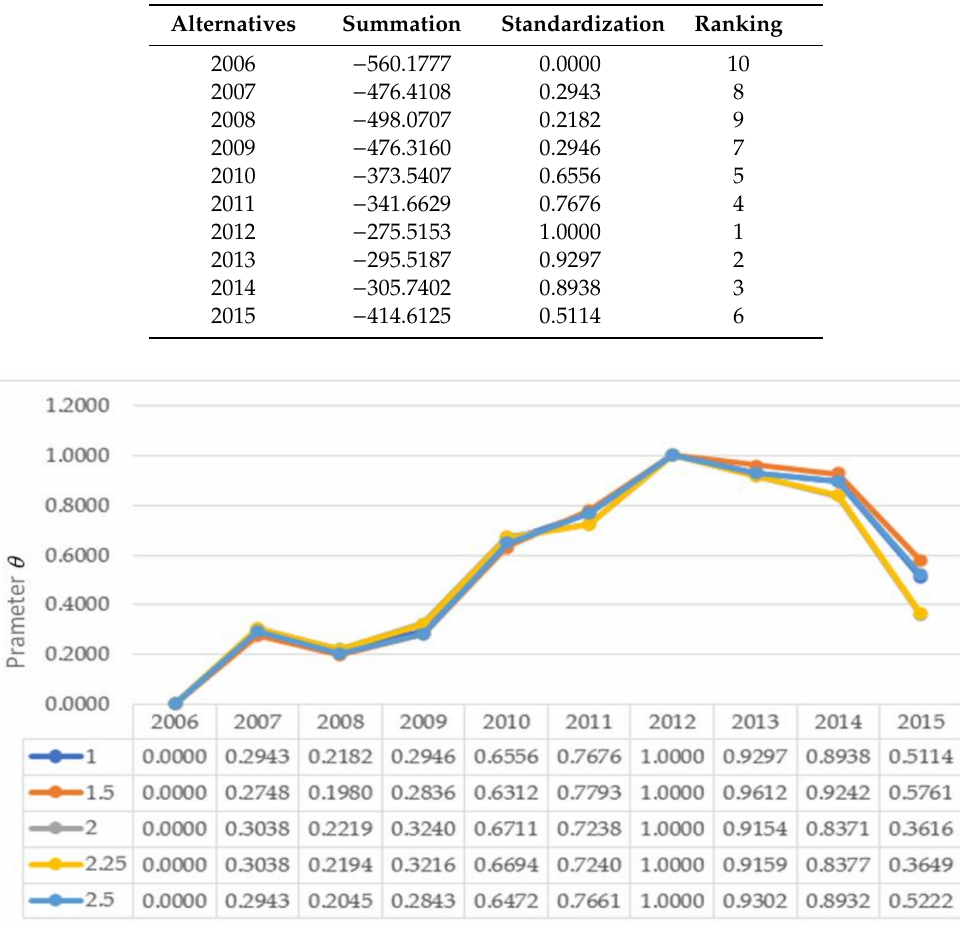
Figure 5. Weights for the criteria on all levels. Table 4. Final values and ordering.